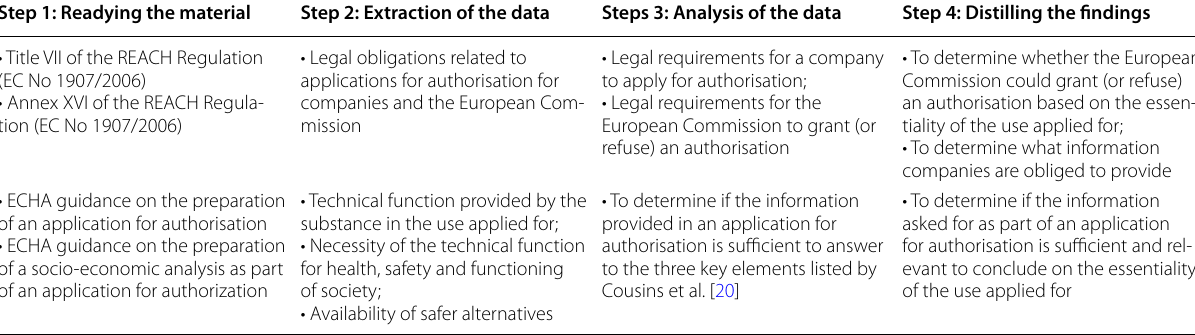
Table 1 Analysis of policy documents following the READ approach